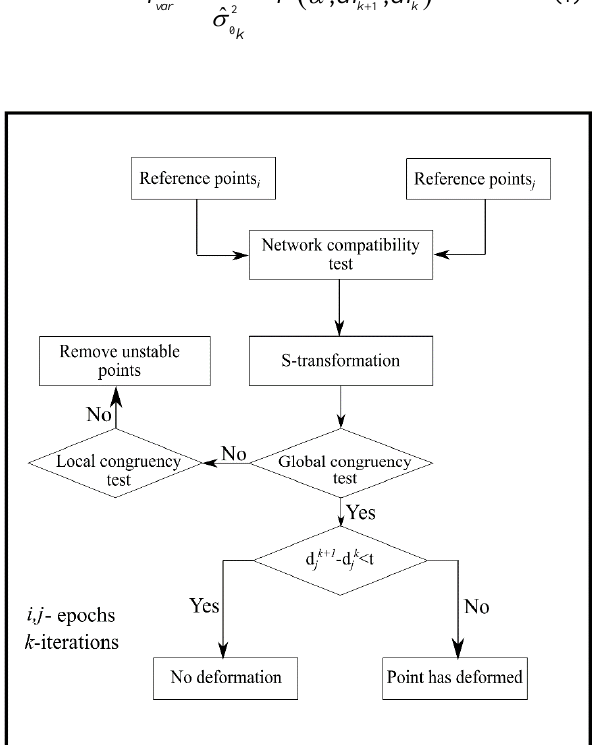
Figure 2. GNSS geodetic network processing for displacement detection and